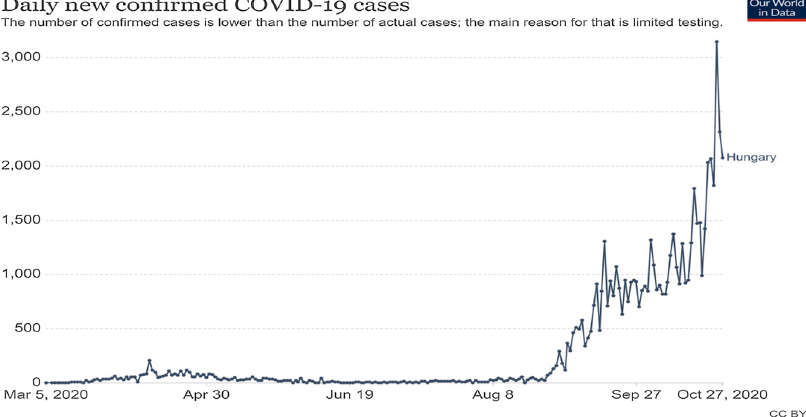
Figure 1: Daily new confirmed COVID-19 cases in Hungary between March 5 and October 27. Source: European Centre for Disease Prevention and Control https://www.ecdc.europa.eu/en/ geographical-distribution-2019-ncov-cases.